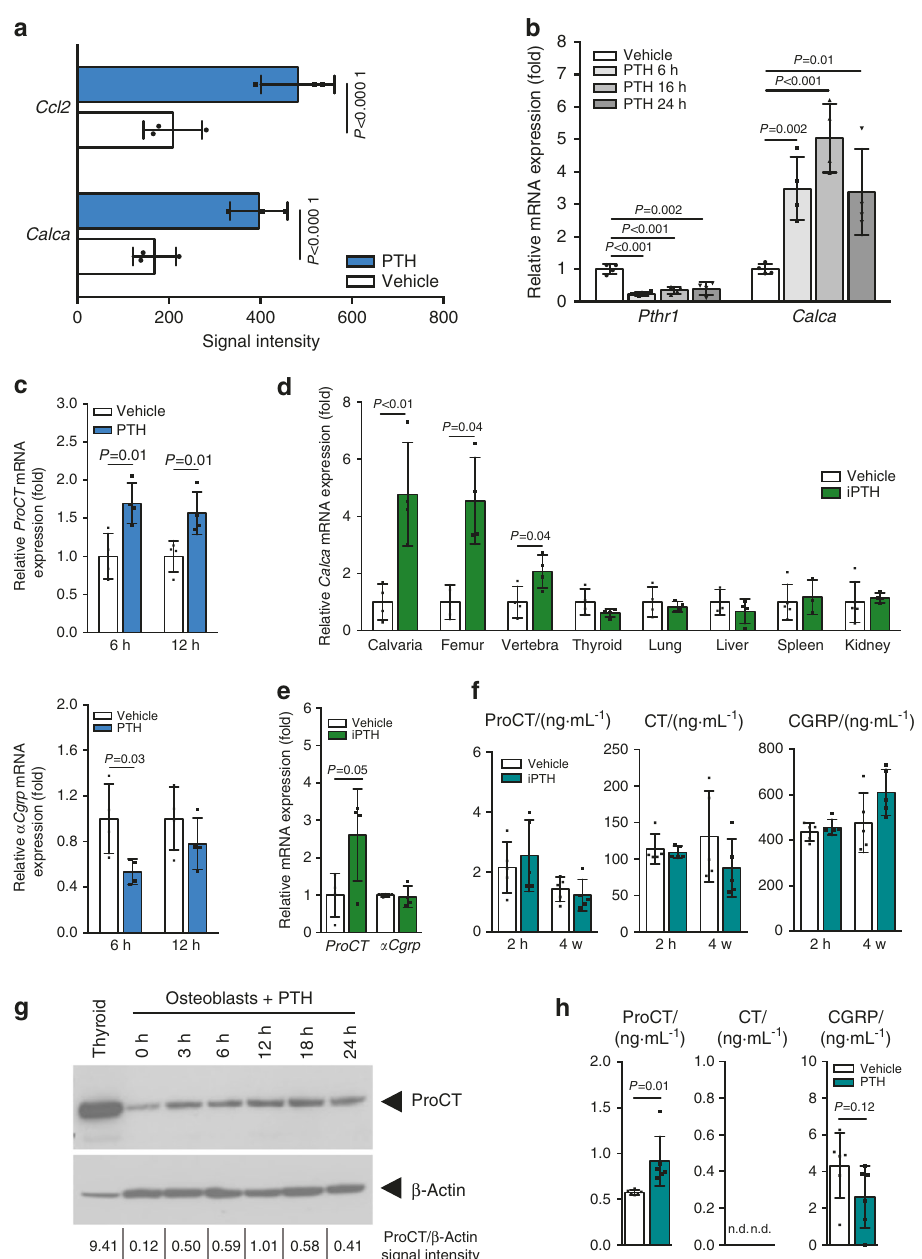
Fig. 1 Calca is a target gene of PTH in osteoblasts. a Affymetrix microarray signal intensities of the indicated genes in calvaria-derived osteoblasts stimulated with PTH (10 − 7 mol·L − 1 ) for 6 h. n = 3 independent experiments per group (Tukey ’ s biweight mean algorithm). b Relative gene expression levels of PTH receptor 1 ( Pthr1 ) and Calca in calvaria-derived osteoblasts (Day 10 of osteogenic differentiation) following stimulation with PTH. n = 4 independent cultures per group (one-way ANOVA followed by Tukey ’ s post hoc test). c Differential expression of ProCT/CT and α Cgrp transcripts (fold) in osteoblasts following 6 and 12 h of stimulation with PTH (10 − 7 mol·L − 1 ). n = 4 cultures per group (unpaired Student ’ s t test). d Relative gene expression levels of Calca (fold) in the indicated tissues of mice treated with iPTH (100 μ g·kg − 1 ) or vehicle for 4 weeks. n = 4 mice per group (one-way ANOVA followed by Tukey ’ s post hoc test). e Relative expression levels of the ProCT/CT and α Cgrp transcripts (fold) in femora of the same mice. n = 4 mice per group (unpaired Student ’ s t test). f Serum concentrations of the indicated proteins in WT mice treated once (serum sampling 2 h after injection) or treated daily for 4 weeks (serum sampling 3 – 4 h after the last injection) with iPTH or vehicle, as measured by ELISA. n = 4-5 mice per group (unpaired Student ’ s t test). g Western blot analysis of ProCT expression in calvaria-derived osteoblasts treated with PTH (10 − 7 mol·L − 1 ) for the indicated durations. The expected band sizes of ProCT (14kD; Cloud Clone Corp. antibody) and beta-Actin (45 kD) are indicated. The ProCT/beta-Actin signal intensity ratios are displayed below. h Concentrations of the indicated proteins in supernatants of osteoblast cultures stimulated with vehicle or PTH for 6 h. n = 6 independent cultures (unpaired Student ’ s t Assessment of cellular bone resorption parameters showed that rate, as assessed by double calcein labeling, was also increased in iPTH treatment did not affect the osteoclast surface in lumbar all iPTH-treated groups. However, the treatment-induced relative spine sections from WT, Calcr -, and α Cgrp -de fi cient mice (Fig. 4a). increase compared to the rate in WT control mice was statistically In sharp contrast, iPTH treatment was associated with an almost signi fi cant only in Calcr -de fi cient mice (Fig. 3c).